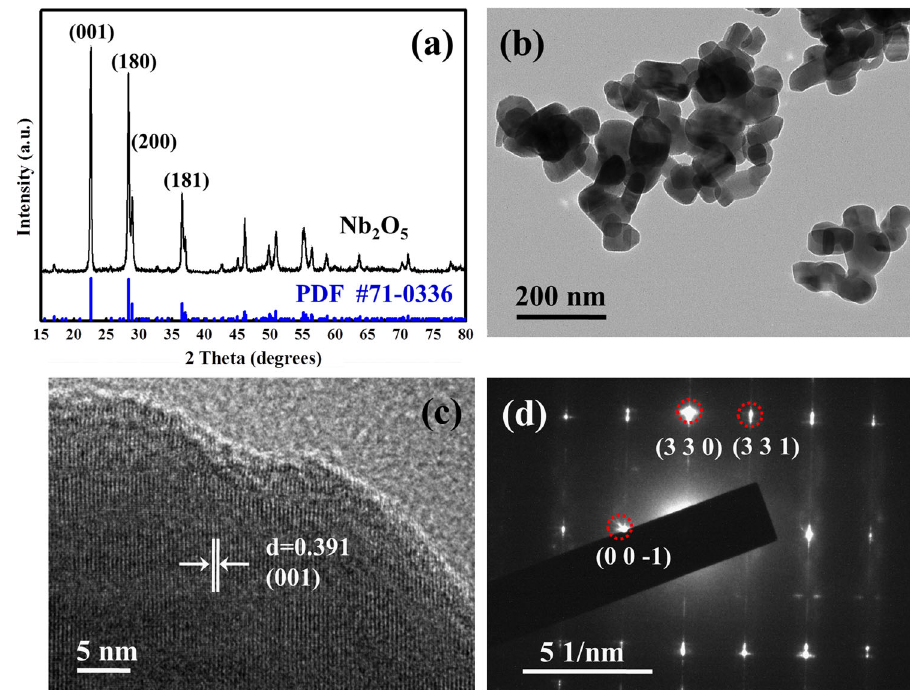
Fig. 1 a XRD pattern for the commercial Nb 2 O 5 , b transmission electron microscope (TEM) micrograph, c HRTEM micrograph, and d SAED pattern of Nb 2 O